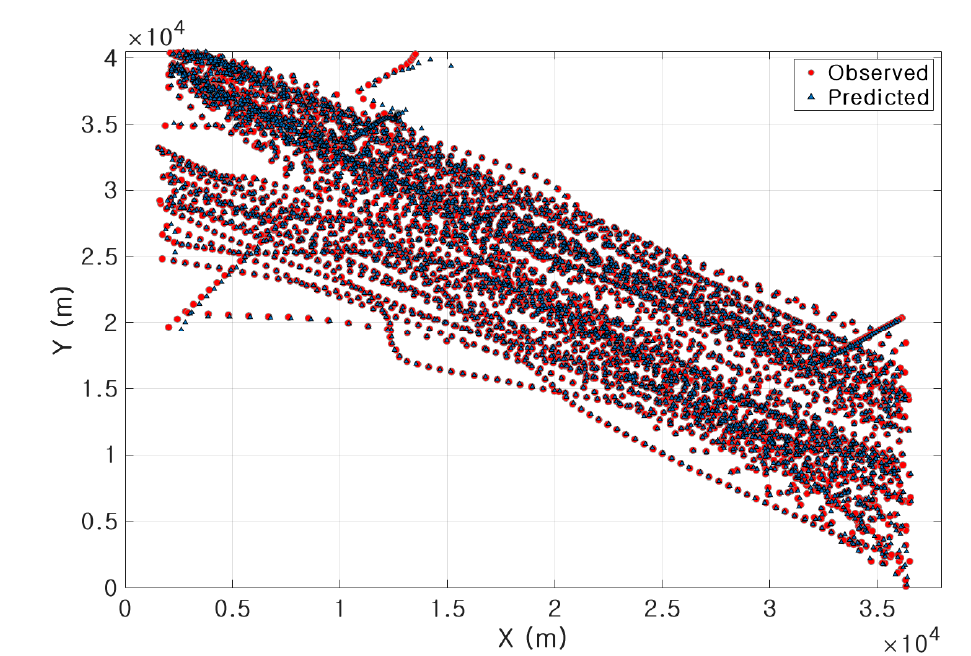
( g ) Predicted trajectory for group B using Bi-LSTM. Figure 8.